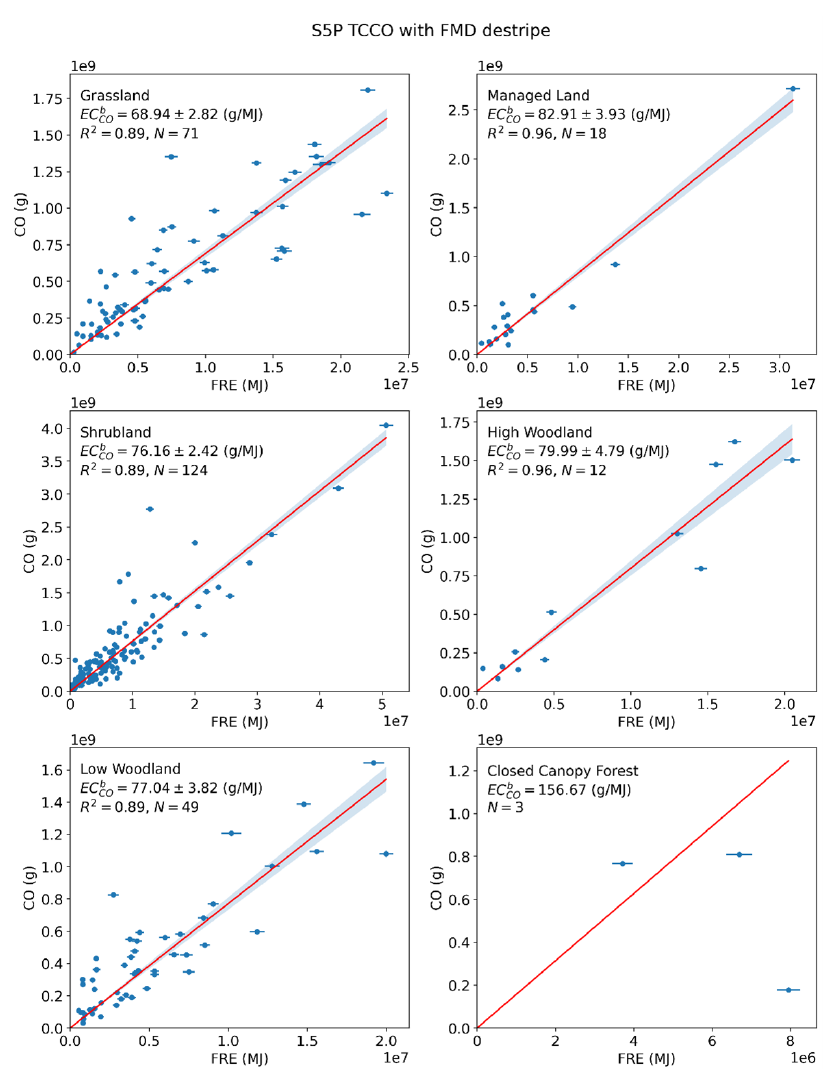
) derived with FMD applied to the S5P TCCO data. CO